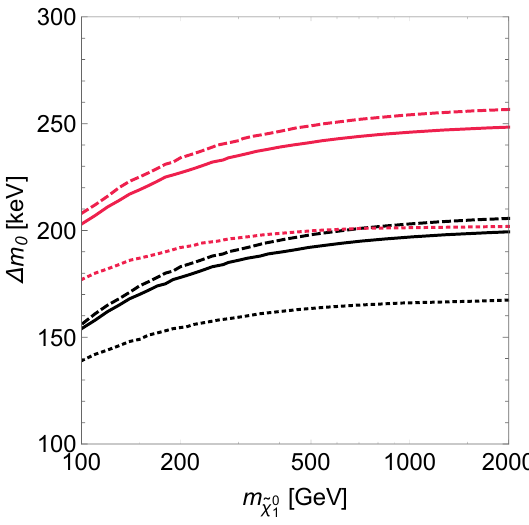
Figure 6 . Constraint on (cid:1) m 0 for given m . The regions below solid, dashed and dotted lines ~ (cid:31) 0 1 are disfavoured at 90% con(cid:12)dence level by the Xenon 1T, Xenon 100 and Xenon 10 data, respec- tively. The upper red lines correspond to v esc : = 650 km/sec while the lower black lines are for v esc : = 500